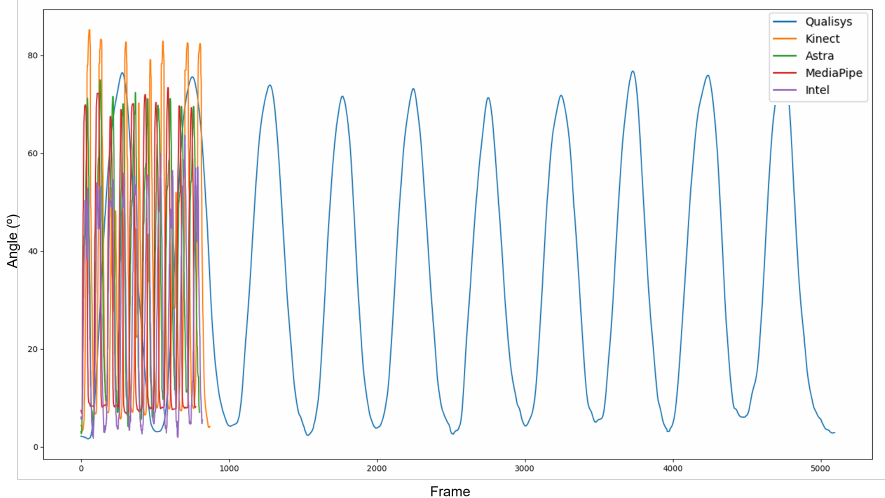
Figure 7. Unsynchronized and interpolated data.